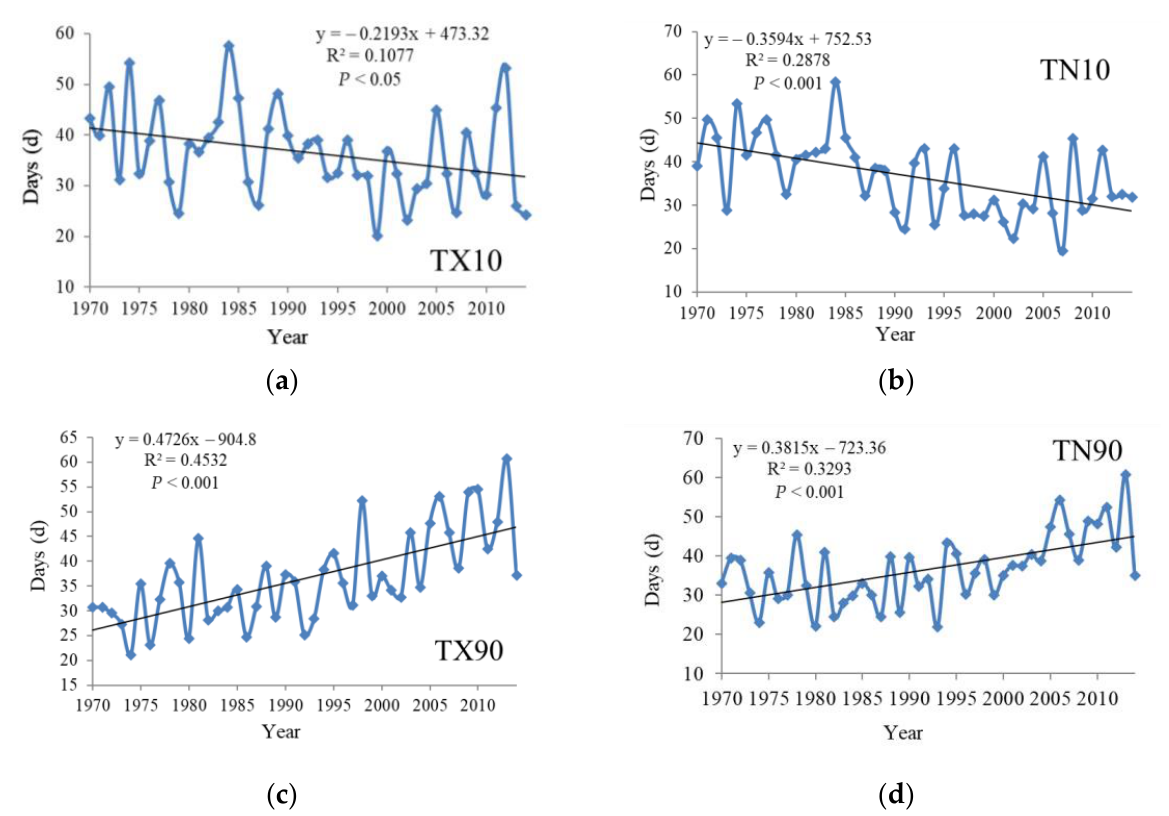
Figure 2. Temporal variation of extreme temperature relative indices in the Yangtze River Basin from 1970 to 2014. ( a ) is TX10, ( b ) is TN10, ( c ) is TX90 and ( d ) is TN90.